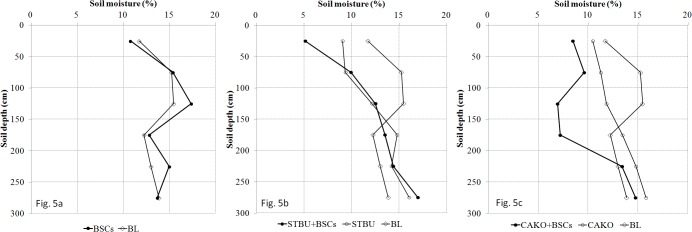
The distribution of soil moisture in the 0–300 cm soil profile at the beginning of the rainy season (20 June 2010).Abbreviations: BL, bare land; BSCs, biological soil crusts; STBU, Stipa bungeana Trin.; CAKO, Caragana korshinskii Kom.